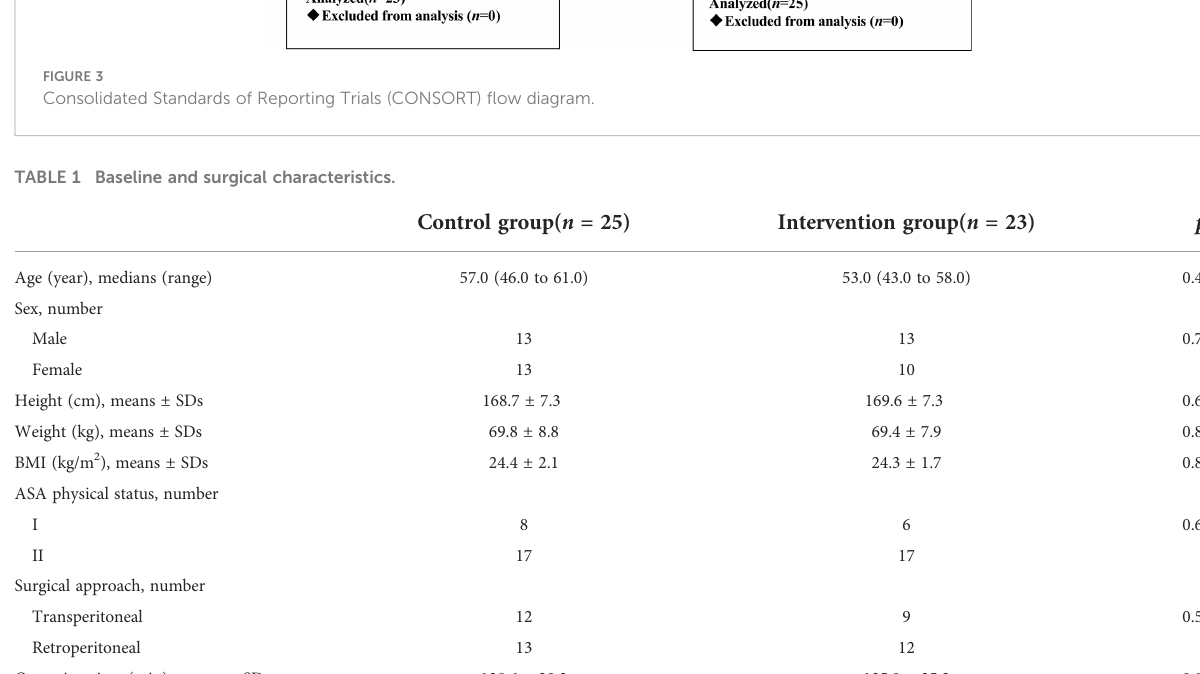
postoperative urinary catheter and drainage catheter removal time ( p > 0.05). There were no signi fi cant differences in nausea, vomiting, respiratory depression, excessive sedation, hypotension, or bradycardia between the intervention group